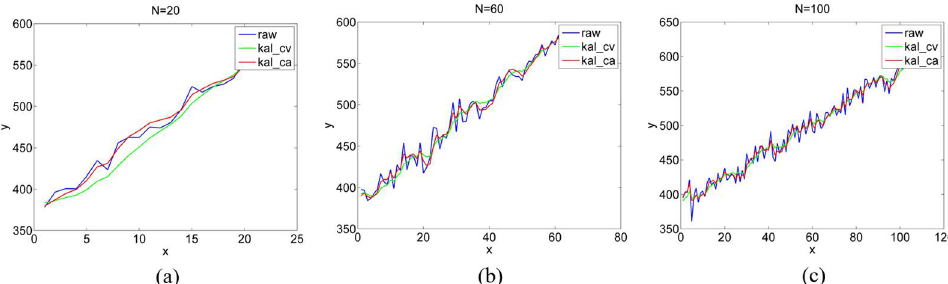
Figure 15. y-values between P6 and P8 with different numbers of motion images. ( a – c ) are y-values between P6 and P8 with 20, 60 and 100 motion images.